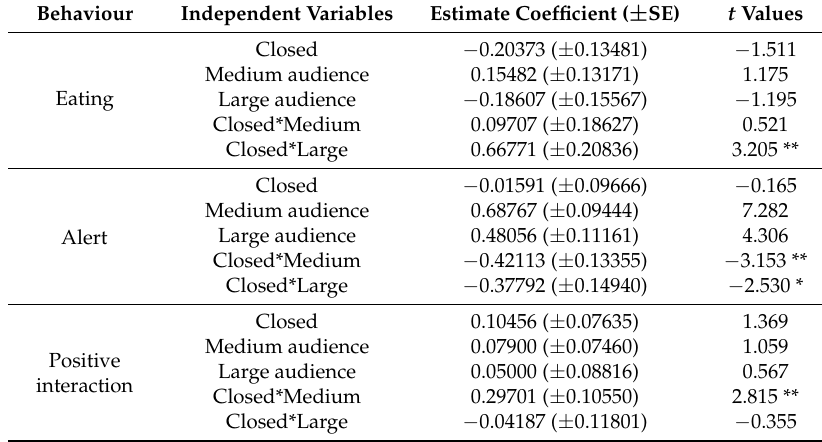
Table 4. Behaviours of zoo mammals significantly affected in the two types of habitat (open and closed) and by public category (small, medium and large).